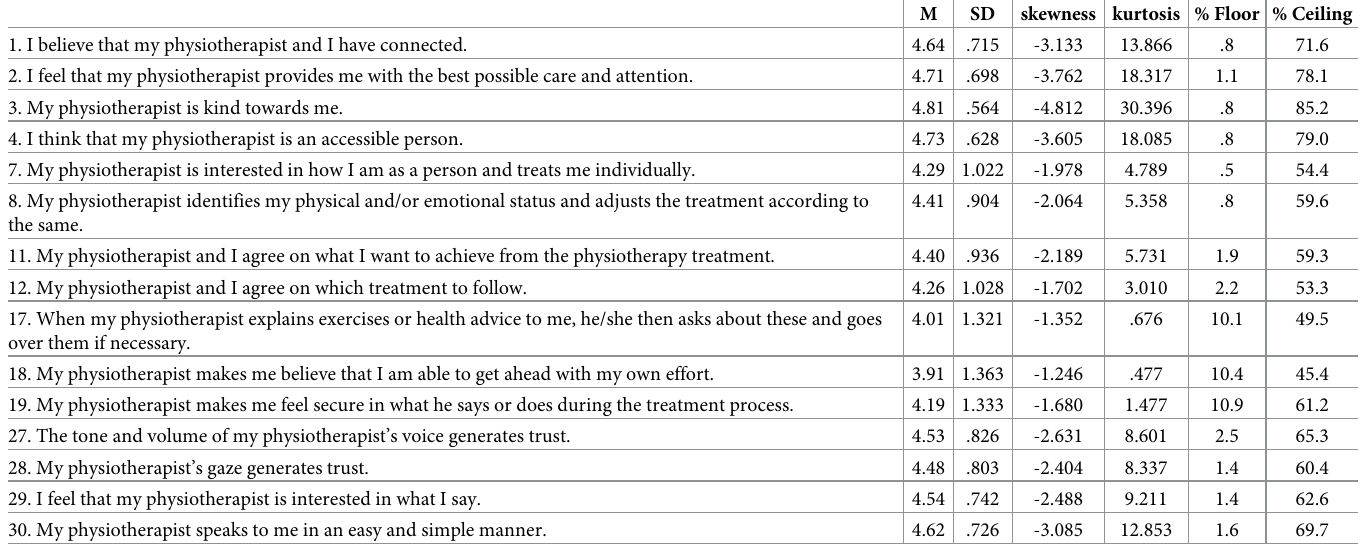
Table 2. Descriptive statistics of the items of the PCTR-PT